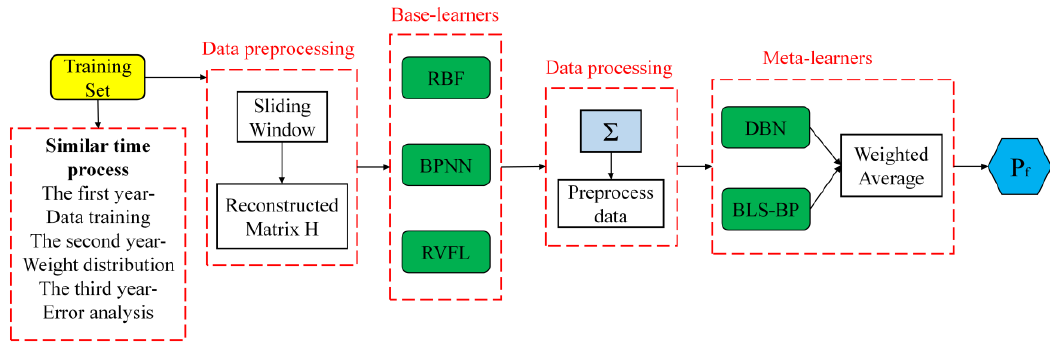
Figure 1. Framework of the proposed model.